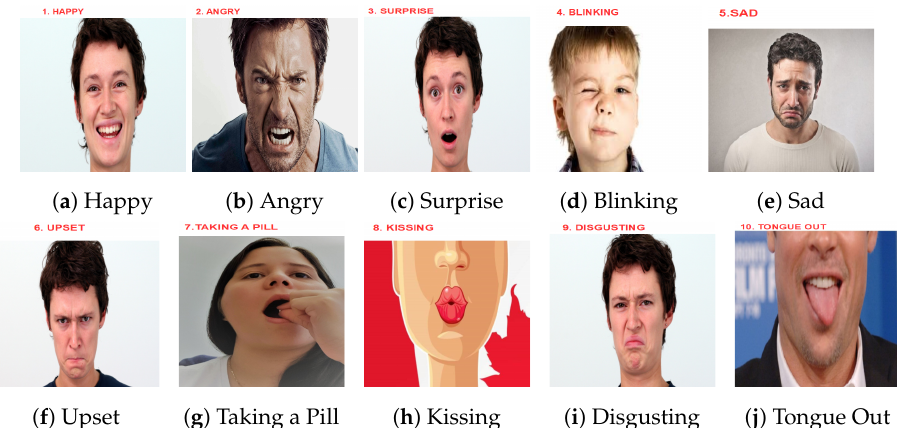
Figure 2. Facial Expressions/Gestures mimicking set; Happiness,upset, sadness, surprise, disgust coming from [6], angry [7] and gestures such as blinking [8], tongue out [9], kissing [10], and taking a